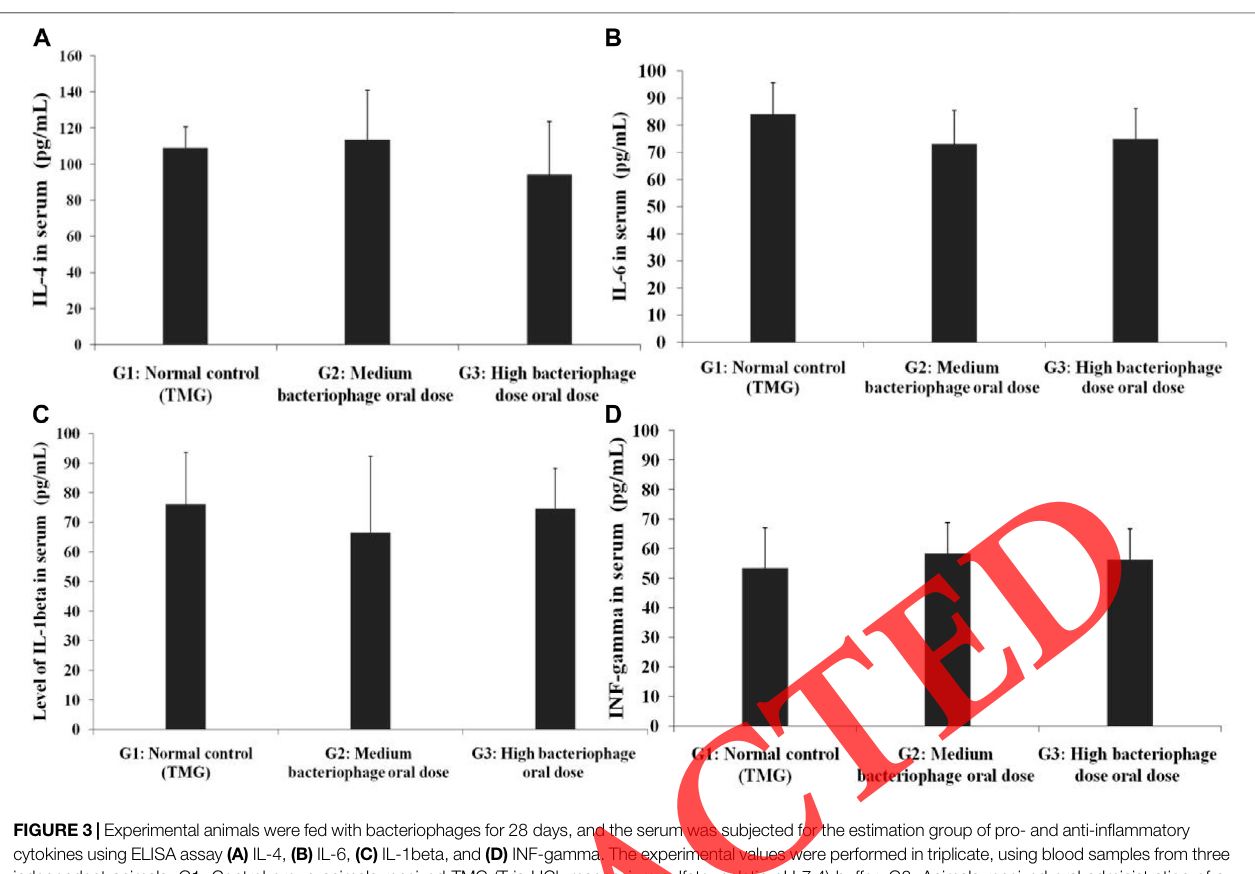
FIGURE 3 | Experimental animals were fed with bacteriophages for 28 days, and the serum was subjected for the estimation group of pro- and anti-in fl ammatory cytokines using ELISA assay (A) IL-4, (B) IL-6, (C) IL-1beta, and (D) INF-gamma. The experimental values were performed in triplicate, using blood samples from three independent animals. G1: Control group animals received TMG (Tris-HCl, magnesium sulfate, gelatin pH 7.4) buffer, G2: Animals received oral administration of a medium dose of bacteriophages (10 15 /ml), and G3: High oral dose of bacteriophages (10 20 /ml). All the values are presented as mean ± SEM ( n (cid:2) 6). No signi fi cant difference could be found among the different groups ( p >